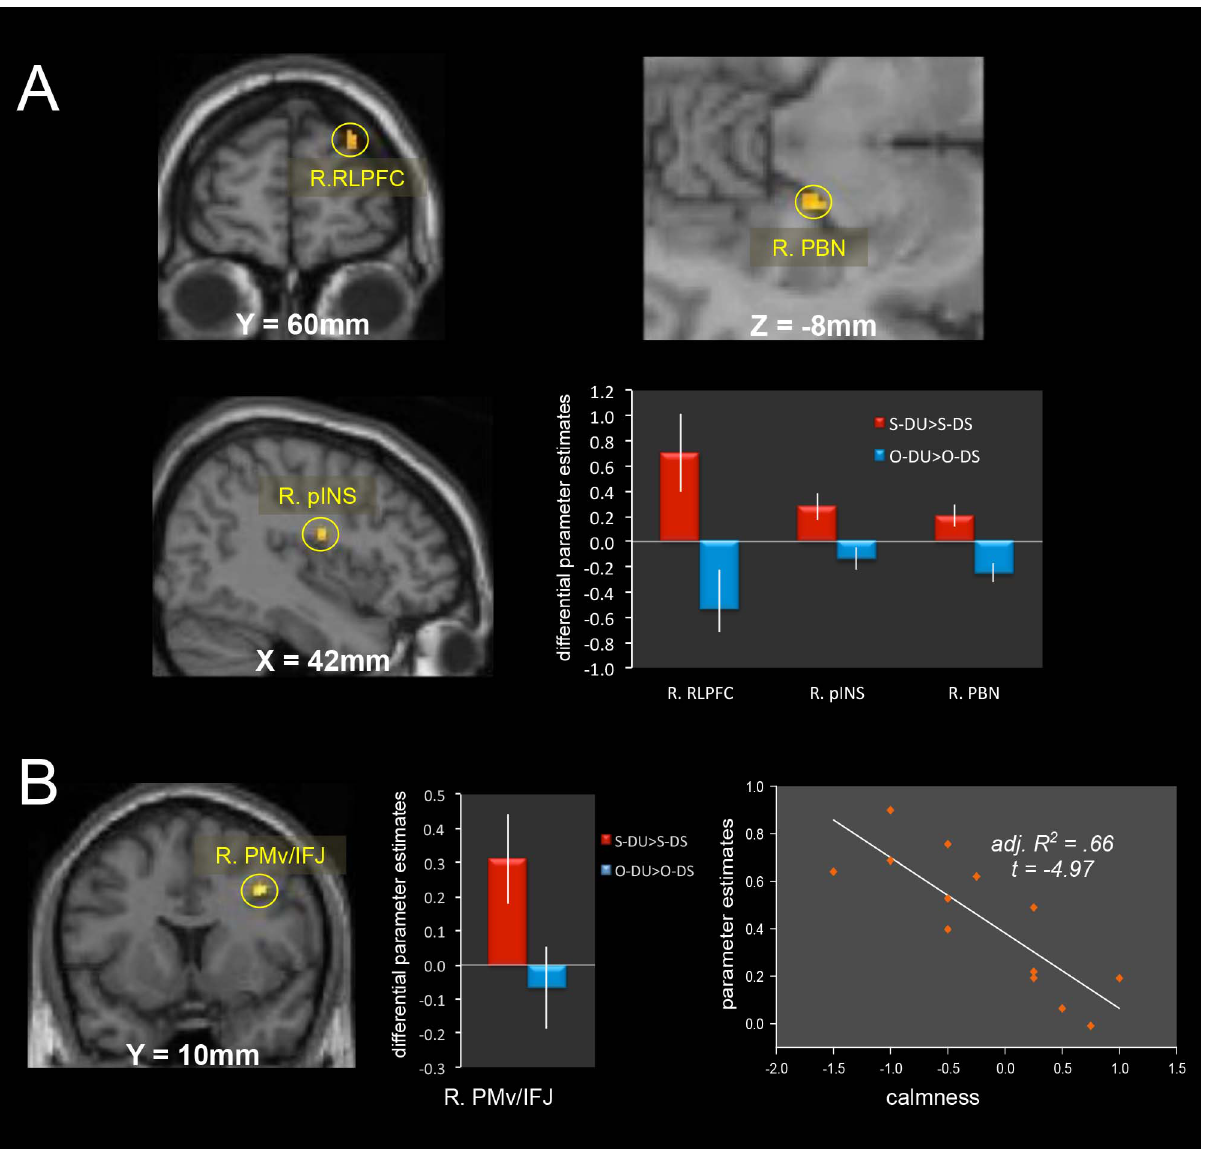
Fig. 4. Self-specific brain activity in the DU vs. DS contrast. A: Brain regions significantly activated for the Self (DU . DS) vs. Others (DU . DS) contrast, and the differential (Self DU (S-DU) vs. Self DS (S-DS), Others DU (O-DU) vs. Others DS (O-DS)) eigenvariate values (parameter estimates, mean ¡ standard error) in the spherical ROI (radius, 5 mm) whose center was the peak voxel at each cluster showing significant activity in the above contrast. B: IFJ/PMv significantly activated for the Self (DU . DS) vs. Others (DU . DS) contrast and its differential eigenvariate values in the spherical ROI (radius, 5 mm) whose center was the peak voxel at each cluster showing significant activity in the above contrast. In addition, this activity showed a negative correlation with subjective calmness ratings. Adj. R 2 : adjusted R 2 , RLPFC: rostral lateral prefrontal cortex, PMv: ventral premotor area, IFJ: inferior frontal junction, PBN: parabrachial